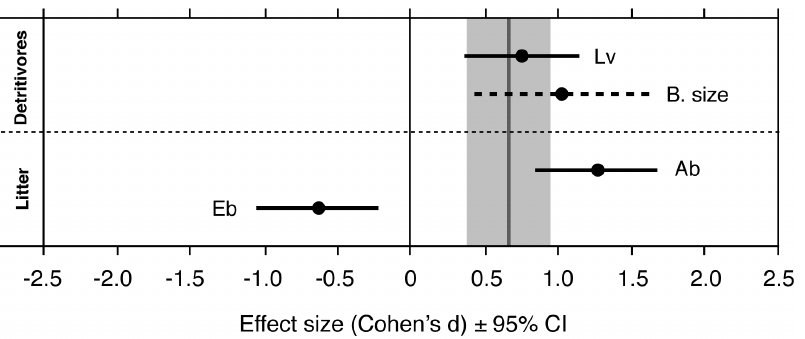
Figure 2. Effect sizes. Effect sizes (Cohen’s d and 95% confidence interval) of detritivore and plant litter assemblages (each monoculture compared to the polyculture; solid bars) and detritivore body size (broken bars) compared to temperature (grey shade), on detritivore-mediated decomposition rates (measured as the proportion of leaf weight loss per capita). Only significant effects are shown. B. size, detritivore body size; Lv, Lectrides varians ; Ab, Apodytes brachystyllis ; Eb, Endiandra bessaphila .